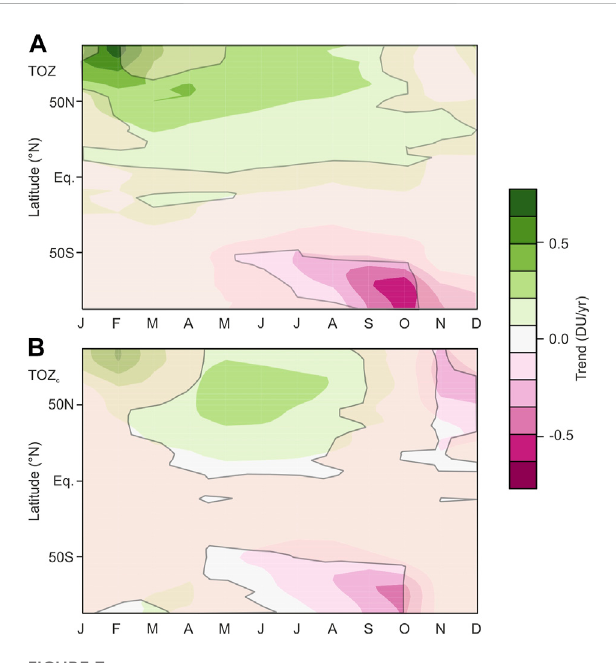
Trends in TOZ (A) and TOZ c (B) over the 1924 – 1963 period as a function of latitude and month. Non-signi fi cant trends ( p = 0.05) are